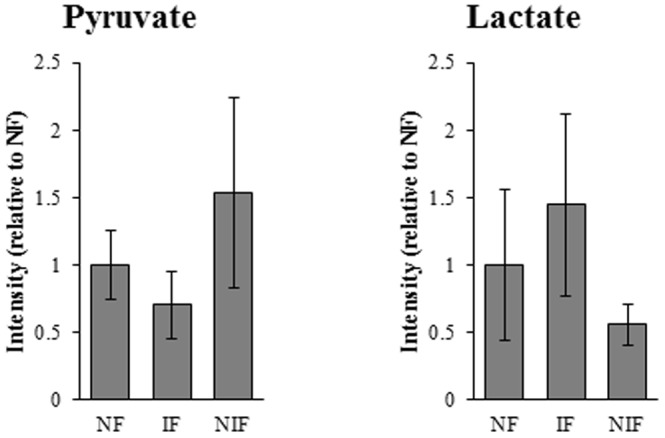
Evaluation of lactate and pyruvate levels in NF, non-failing; IF, ischemic failing; NIF, non-ischemic failing human myocardial tissues.Data is reported as fluorescent intensity relative to NF tissue.